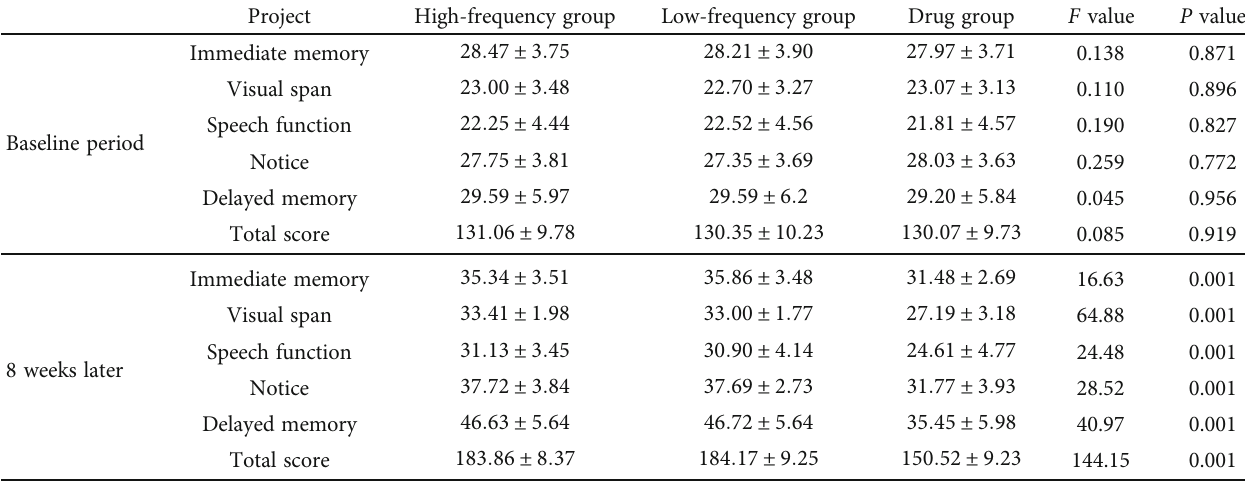
Table 6: Comparison of repeatable neuropsychological state measurements in each group ( (cid:1) x ± s ).